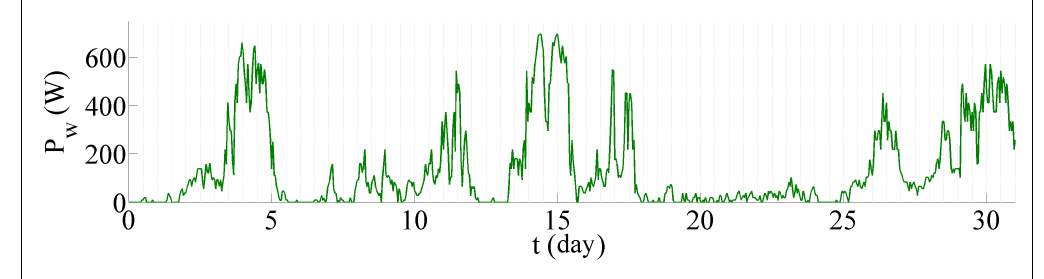
Figure 4. The power generated by the wind turbine during the first 31 simulation days.